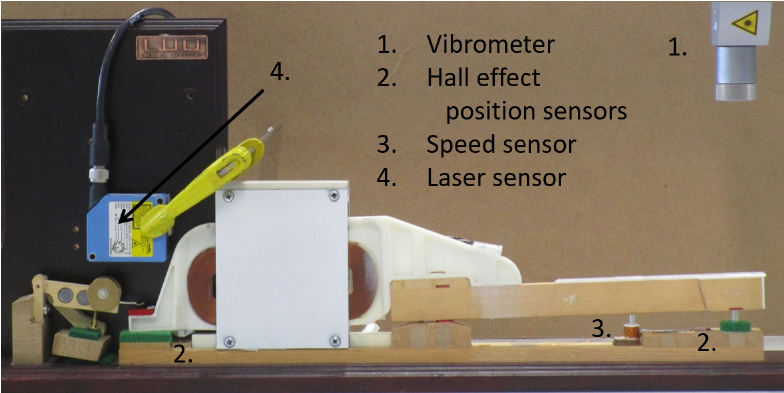
Figure 18. Piano haptic key: kinematics sensing validation. First, the position estimation is experimented by manually applying up and down movements to the key, as shown in Figure 19.